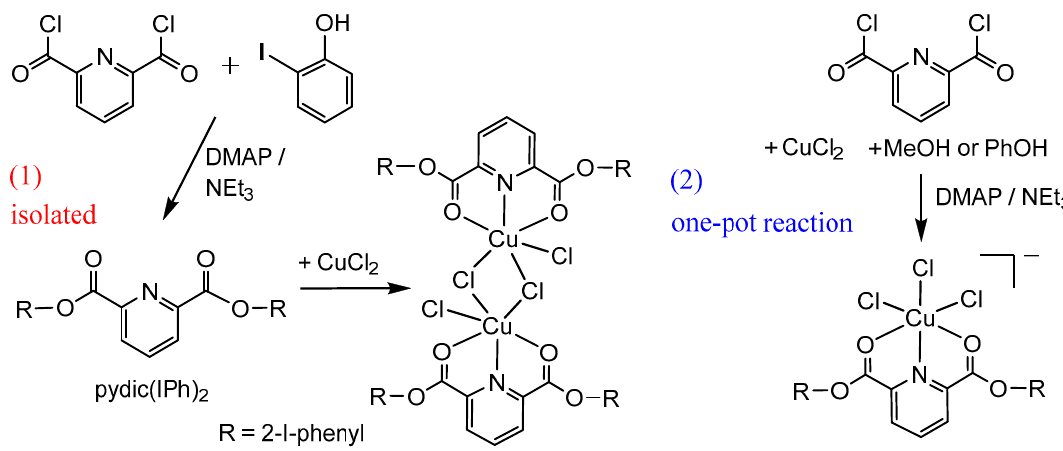
Scheme 2. Two reaction strategies to synthesize Cu II complexes of pydicR 2 ligands (DMAP = dimethyl 4-aminopyridine).